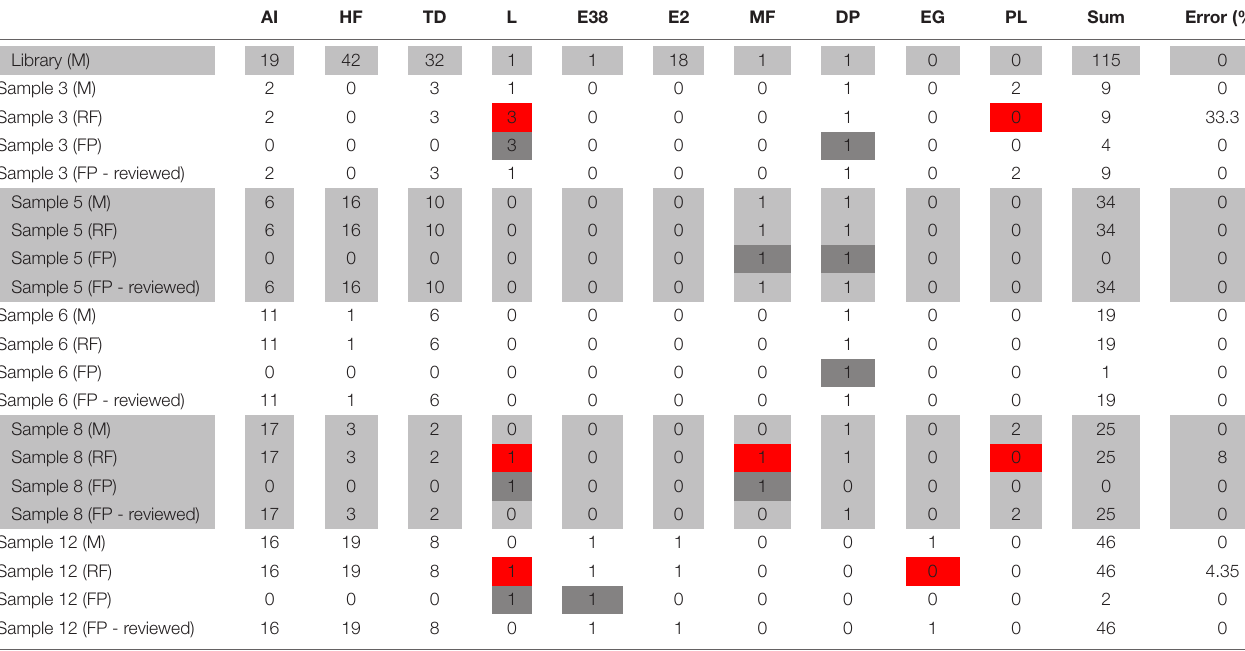
TABLE 2 | Number of specimens identified for all samples morphologically (M) and classified by Random Forest